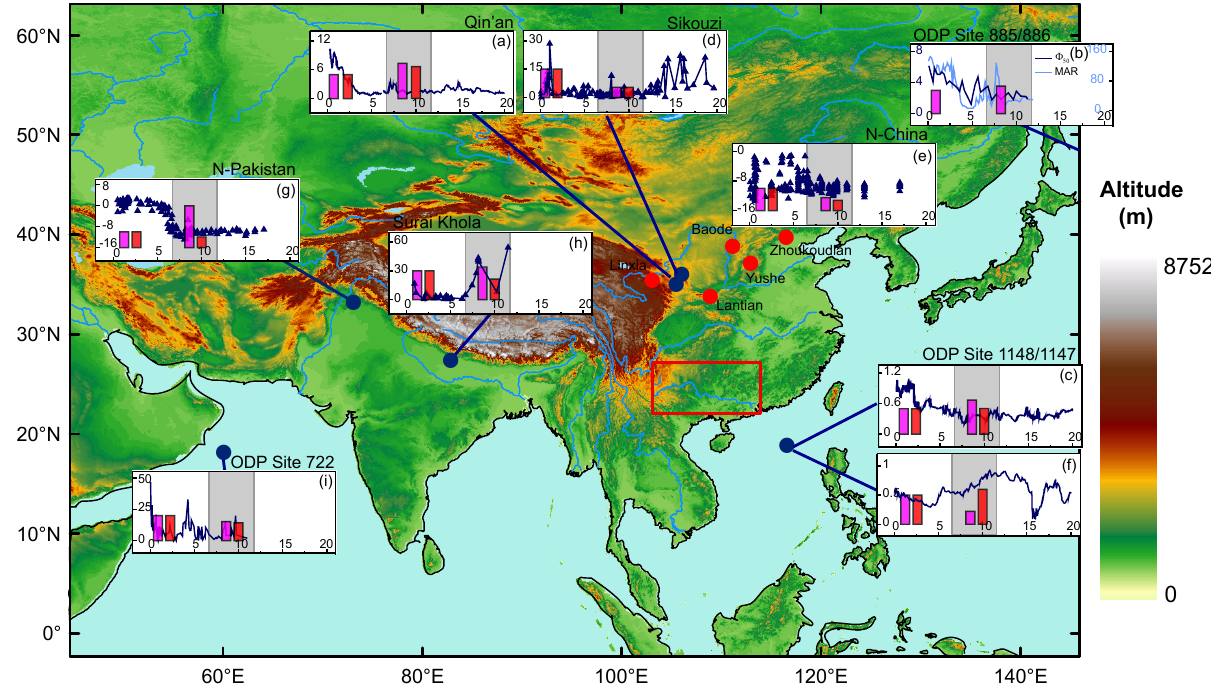
Fig. 9. Proxy records of the Asian monsoon variation in the Neogene and the comparison with the global model (purple bars – left: GCTRL; right: GTORT) and regional model (red bars – left: CTRL; right: TORT) results. (a) Dust accumulation rate (cmkyr − 1 ), Loess Plateau, N-China (Guo et al., 2002); compared with the 500hPa wind speed (DJF) at the same locality in the model. (b) Mass accumulation rate (right axis, mgcm − 2 kyr − 1 ) and grain size (left axis, φ 50 ), ODP site 885/886 (Rea et al., 1998); compared with the 500hPa wind speed (DJF). (c) Black carbon accumulation rate (mgcm − 2 kyr − 1 ) ), ODP site 1147/1148 (Jia et al., 2003); compared with the 850hPa wind speed (DJF); (d) Humidity index, Sikouzi, N-China (Jiang and Ding, 2008); compared with the mean annual precipitation; (e) δ 13 C (‰, VPBD) of tooth enamel, localities denoted by red dots, N-China (Passey et al., 2009); compared with the mean JJA-precipitation; (f) Chemical weathering index ( C RAT ), ODP site 1148 (Clift et al., 2008); compared with the mean annual runoff over the reach of Pearl river as denoted by the red rectangle; (g) δ 13 C (‰, PBD) of pedogenic carbonate, northern Pakistan (Quade et al., 1989); compared with the mean JJA-precipitation; (h) Quercus (%), Central Nepal (Hoorn et al., 2000); compared with the mean annual precipitation; (i) G. Bulloides (%), ODP site 722 (Huang et al., 2007); compared with the 850hPa wind speed (JJA). In all cases, the x-axis represents the age (Ma). The light gray shaded area denotes the Tortonian (11–7Ma). All the bars are shown in relative